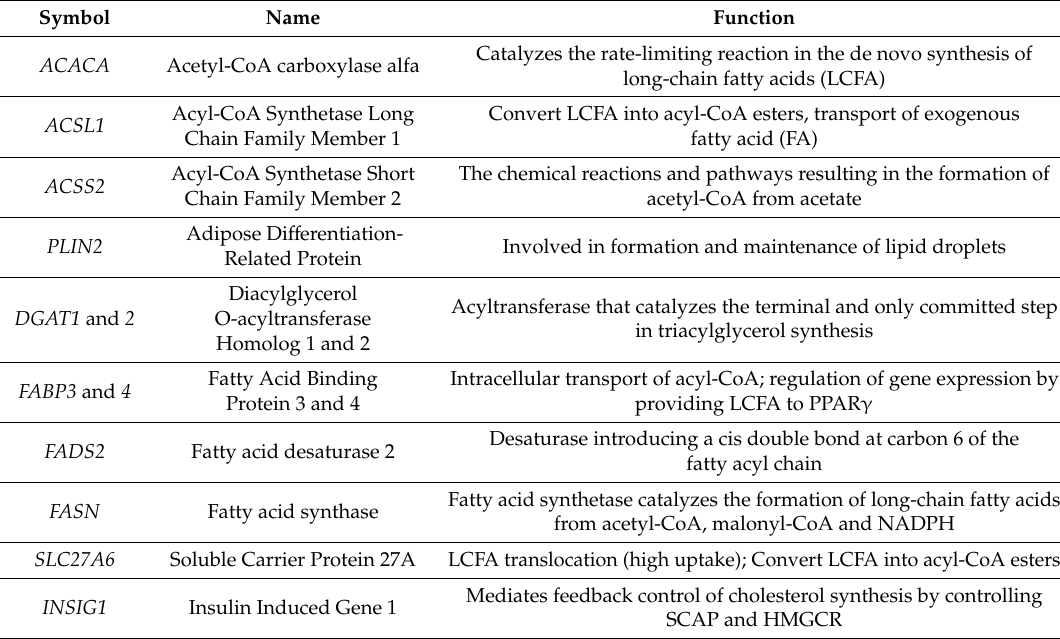
Table 1. Gene symbol, name, and lipogenesis-related functions of the 20 genes measured in the present